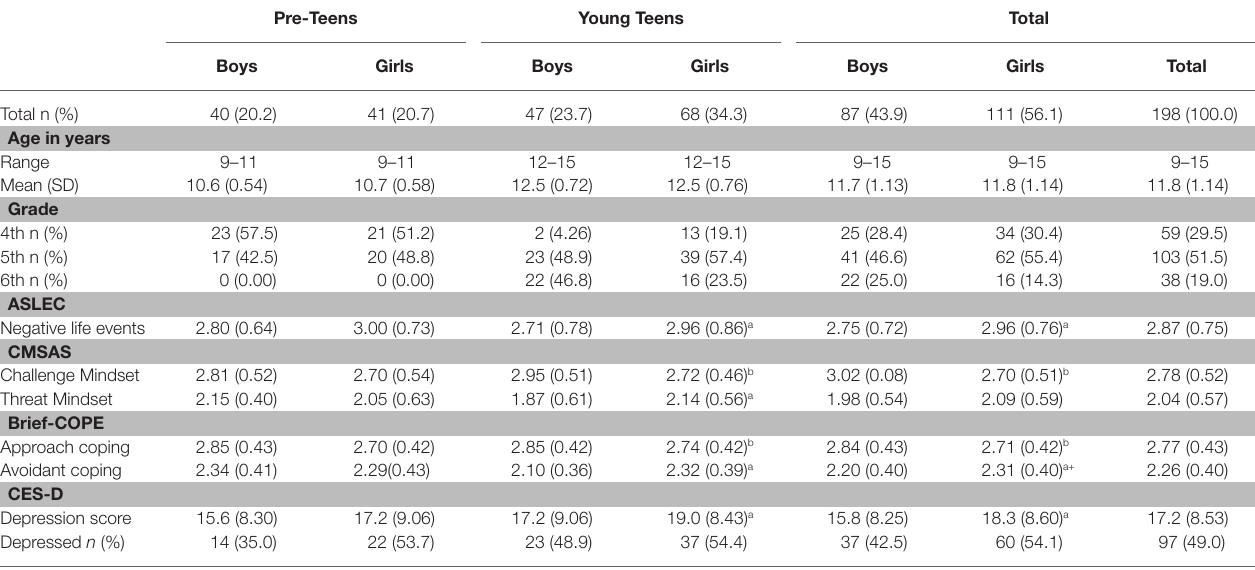
TABLE 1 | Characteristics of the study sample and descriptive statistics of the main variables.